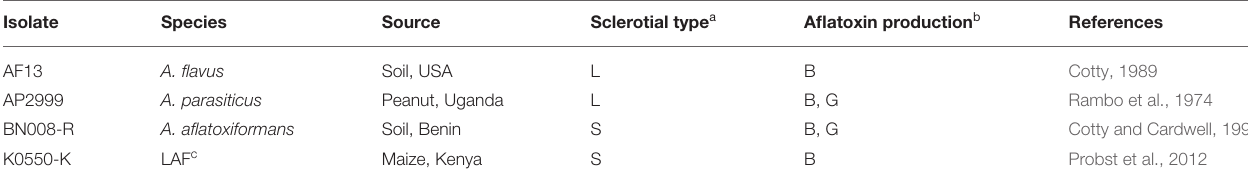
TABLE 1 | Aspergillus isolates used in the current